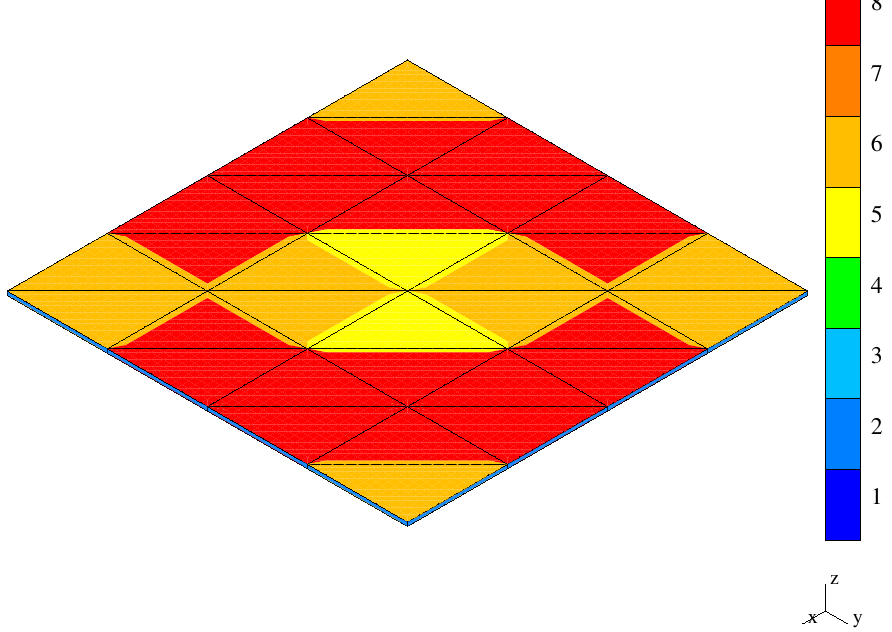
Figure 19. A bending-dominated plate—mesh after optimization and hp